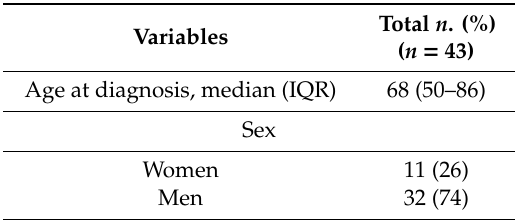
Table 1. IQR: interquartile